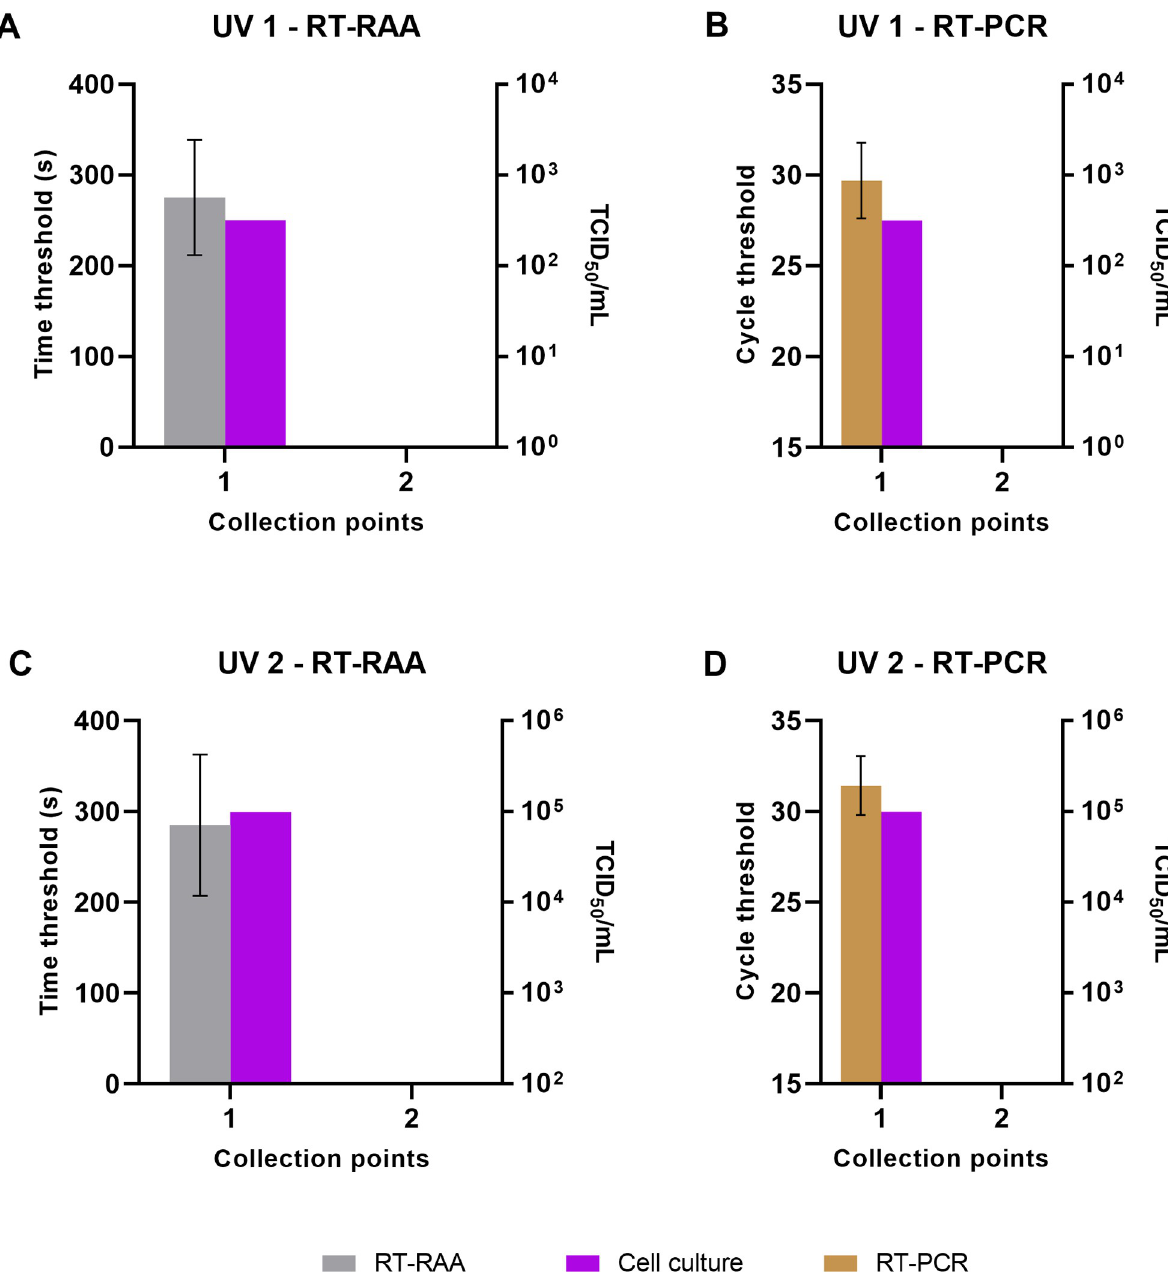
Fig 6. Effectiveness of two UV-C lamps in inactivating infectious virus particles. Collection point #1 represents samples taken in front of the air purifier, while collection point #2 represents samples collected after air purification. Samples collected before the air purification have the expected concentration of viruses in cell culture as well as in RT-RAA and real-time RT-PCR. Enzyme pretreatment of the samples from collection point #2 results in absence of signals in both RT-RAA (A and C) and real-time RT-PCR (B and D).